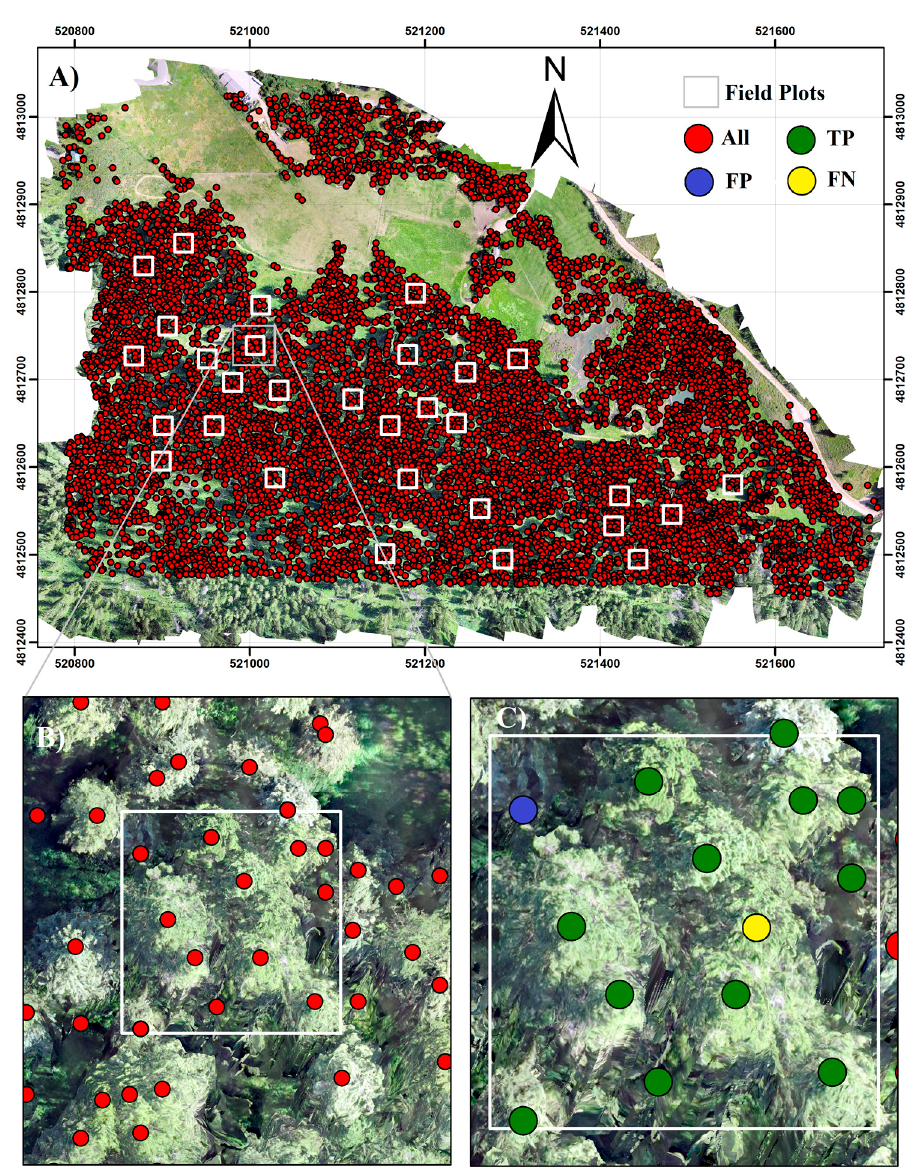
Figure 4. Individual tree detection from UAV-derived Canopy Height Model (CHM). Red dots represent the tree tops detected in the study area at stand level ( A ), and plot level (Plot 19) ( B ). Blue and yellow dots represent the commission (FP) and omission (FN) errors while the green dots represent the true positive trees (TP) at the plot 19 and ( C ).